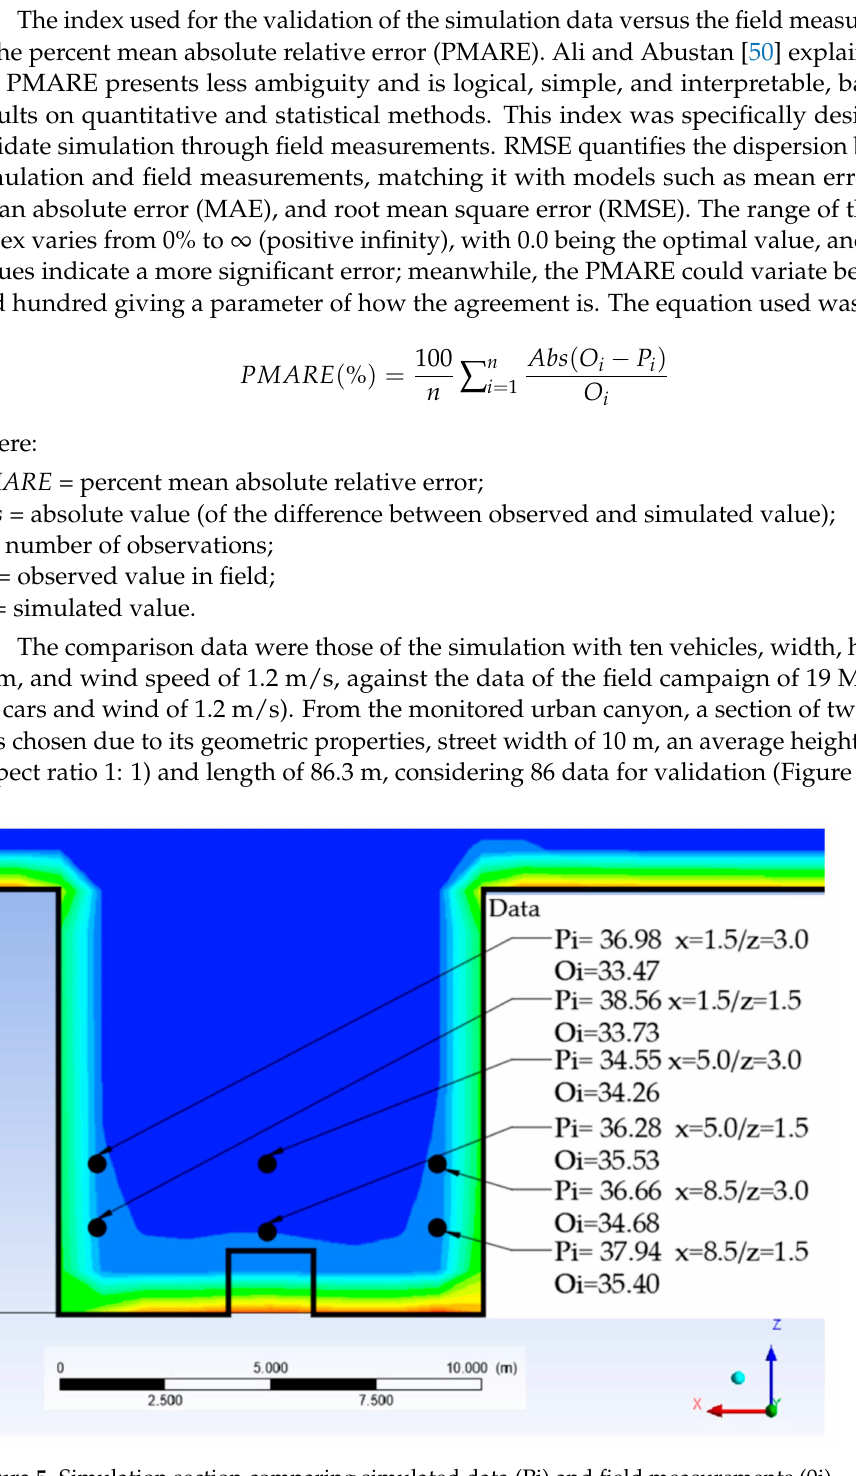
Figure 5. Simulation section comparing simulated data (Pi) and field measurements (0i). The Pi values were the six lines average in their different locations, at the height of 1.5 and 3.0 m on the right sidewalk, in the middle of the street, and on the left sidewalk, as were the values for Oi, designated to the same height and